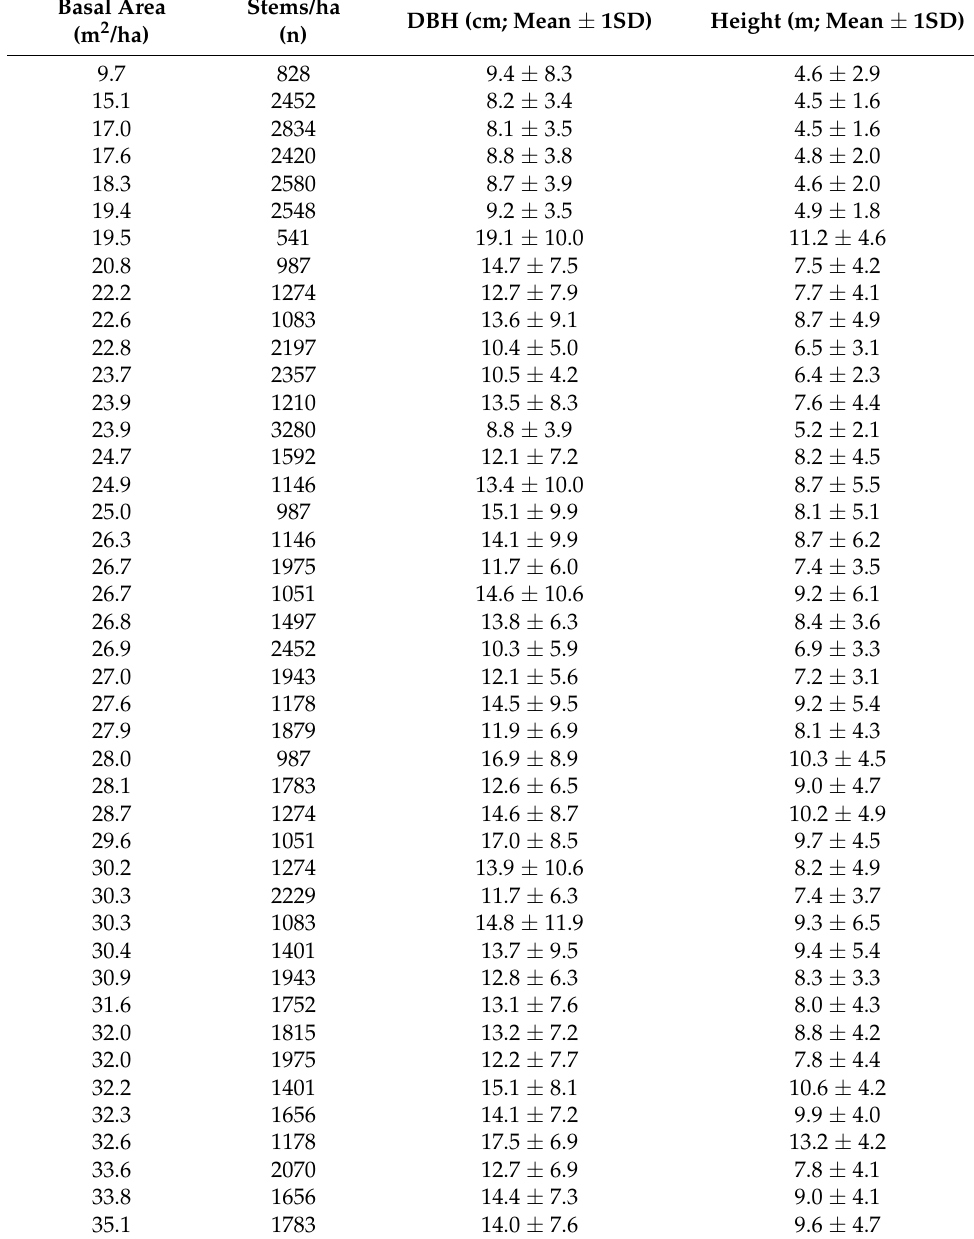
Table A1. Summary of Biometric Data for Field